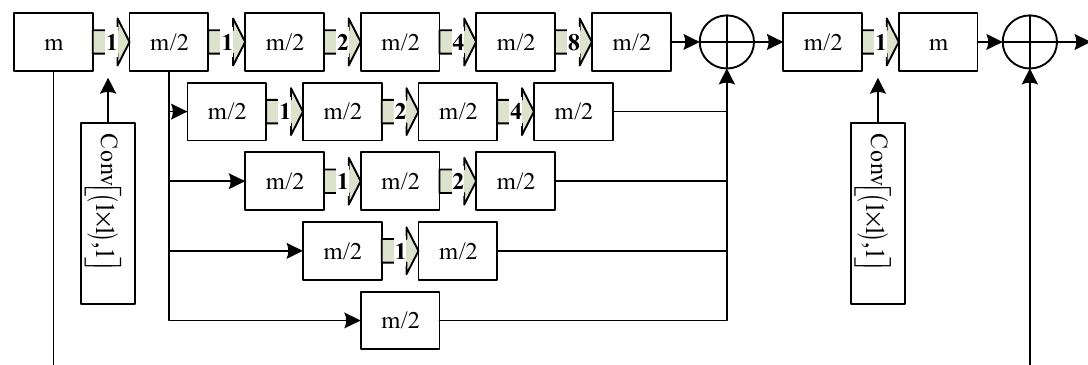
Figure 10. The structure of DBlockPlus.